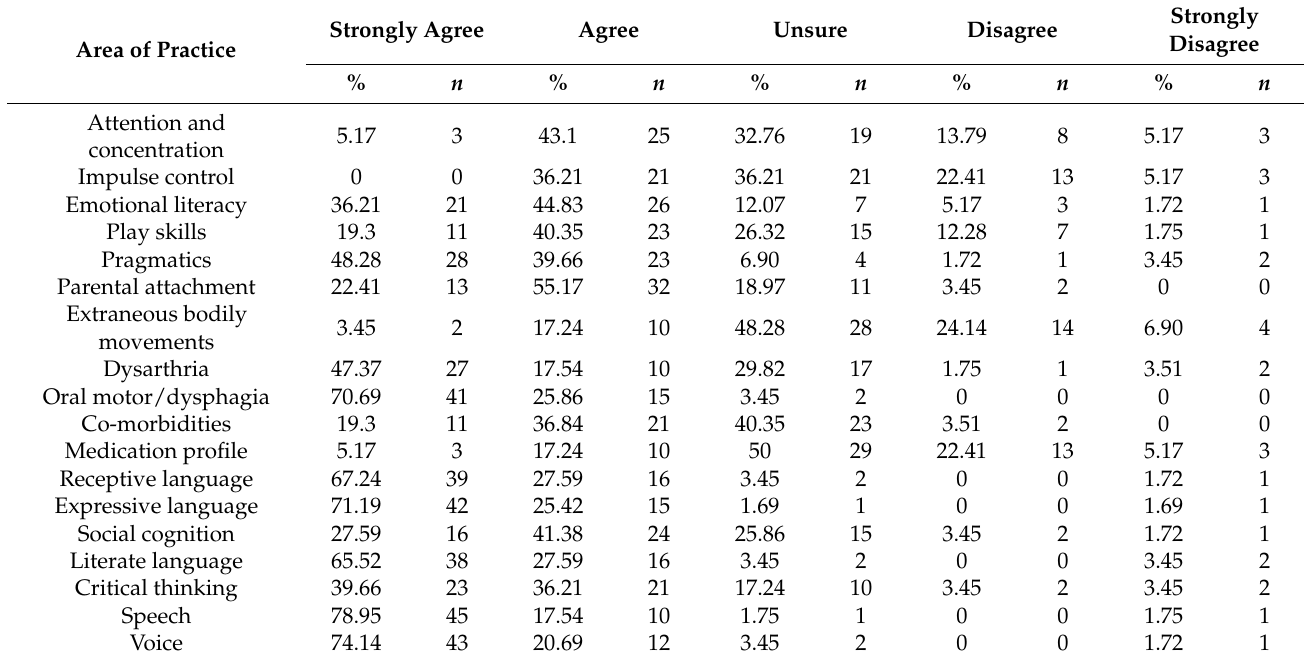
Table 2. Areas of practice for speech pathologists.